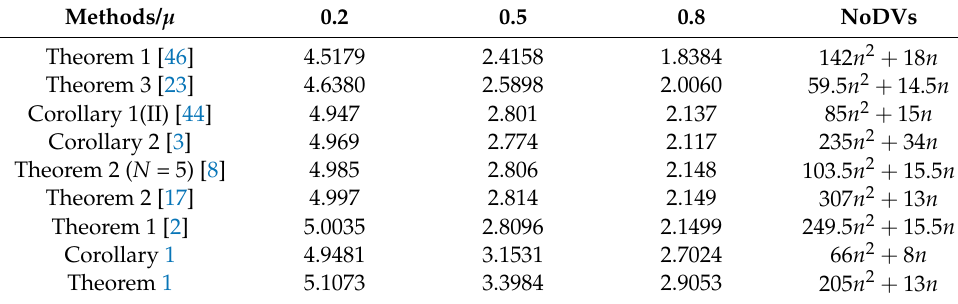
Table 2. The MDUB h for different µ in